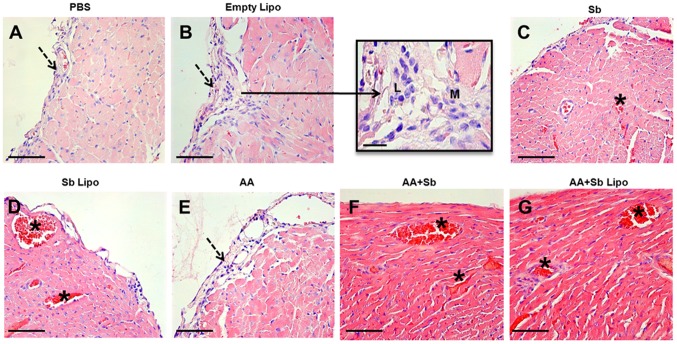
Histopathological analyses of the heart from L. infantum infected mice submitted to different treatment regimens.(A) Phosphate-buffered saline (PBS). (B) Empty liposomes (Empty Lipo). (C) Trivalent antimony (Sb). (D) Antimony entrapped liposomes (Sb Lipo). (E) Ascorbic acid (AA). (F) Ascorbic acid in association with antimony (AA+Sb). (G) Ascorbic acid in association with antimony entrapped liposomes (AA+Sb Lipo). Bar  = 50 µm. Insert  = 25 µm, representing an inflammatory infiltrate of lymphocytes (L) and macrophages (M). Dashed arrow  =  subendocardial inflammatory infiltrate composed of mononuclear cells. * Active hyperemia.